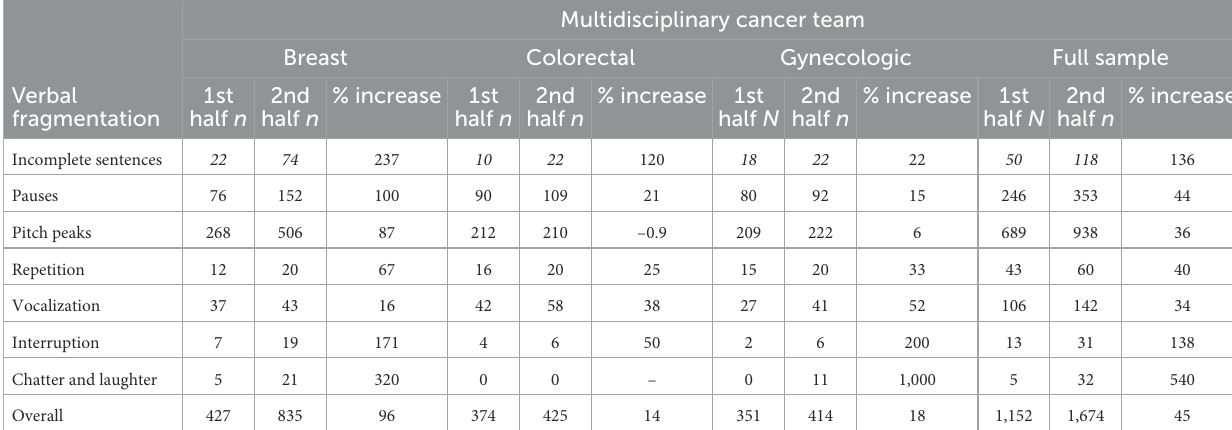
TABLE 6 Frequency and percentage increase in verbal fragmentation in the first vs. the second half of meetings across the participating cancer multidisciplinary teams (MDTs). Multidisciplinary cancer